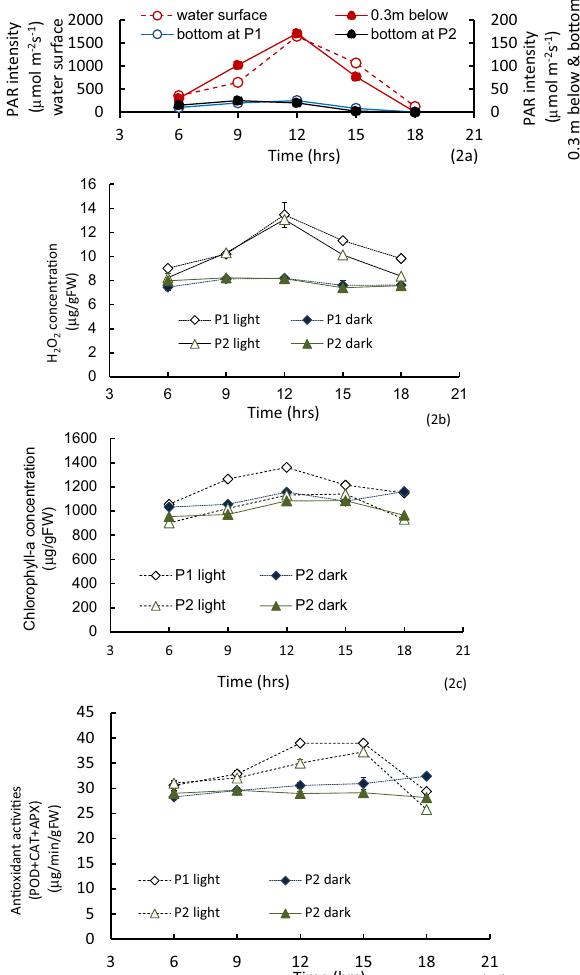
Figure 2. The variations of PAR intensity at water surface, 0.3 m below the surface, at bottom of sampling points, P1 and P2, H 2 O 2 concentration of tissue samples at light- exposed and shaded samples of P1 and P2 points, and the sum of three antioxidant enzyme activities of tissue samples at light-exposed and shaded samples of P1 and P2 points. Vertical bars indicate the standard